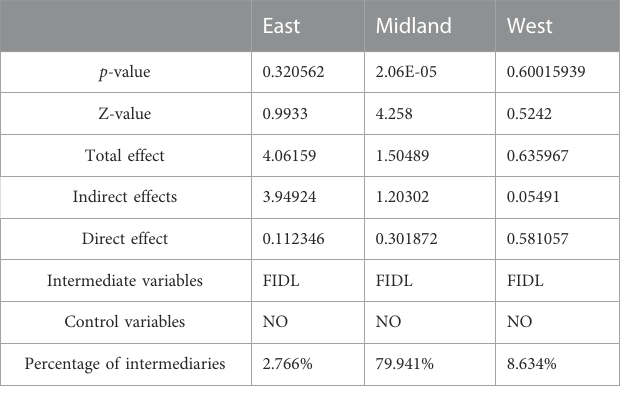
TABLE 11 Overall results for the three regions with fi nancial sector development as a mediating variable.